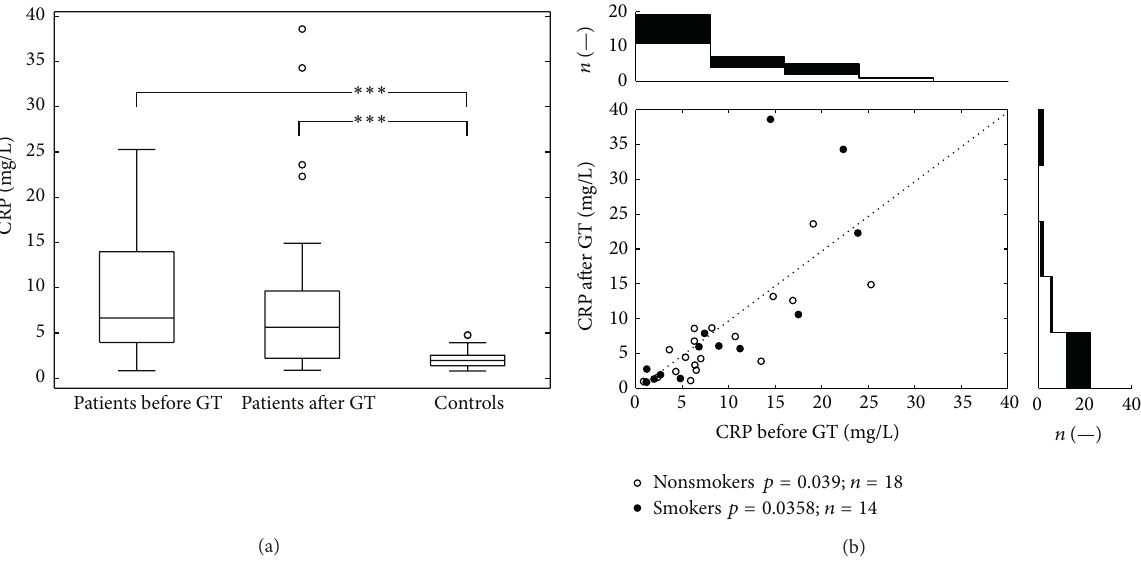
Figure 1: The variation in CRP values. (a) depicts intergroup comparisons of serum levels of CRP using Wilcoxon rank sum test (patients beforeandafterGTversuscontrols).PatientsshowedbeforeandafterGTsignificantlyhigherCRPlevelsthancontrols( 𝑝 < 0.001 ).(b)(scatter plot) depicts serum CRP levels before and after GT in patients. Pairwise comparison (Wilcoxon signed rank test) indicated a decrease of the CRT level ( 𝑝 < 0.05 ). For smokers (black dots) and nonsmokers (open circles) statistics see the plot legend. All together 32 dots represent 64 measurements; each dot belongs to one patient. The top histogram shows data distribution before the treatment; the right side histogram corresponds to the posttreatment values